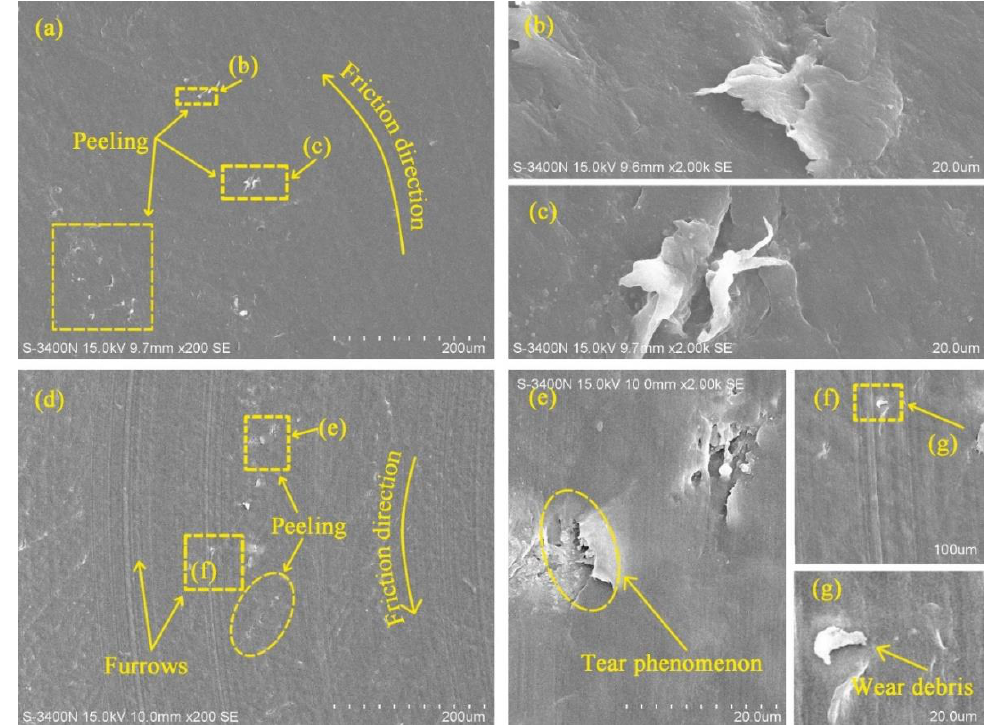
Figure 4. SEM micrographs of worn surfaces of UHMWPE under water-unsaturated lubrication ( a ) 50 N load and ( d ) 110 N load; ( b , c ) and ( e – g ) are the images taken at the marked positions in the micrographs.